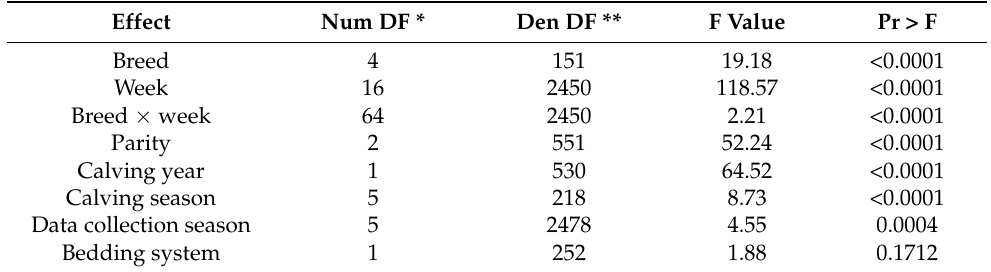
Table A1. Variance analysis results for the variable body condition score